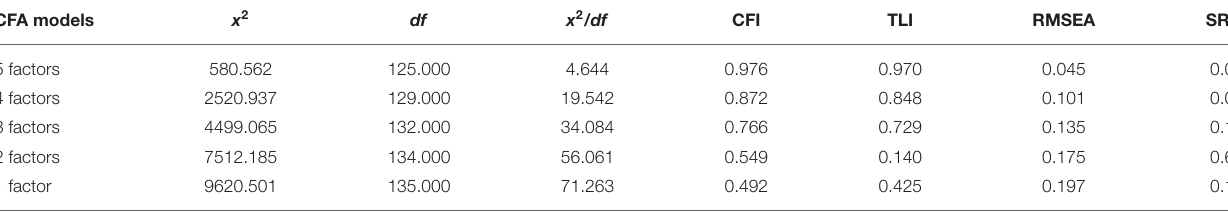
TABLE 2 | Testing the discriminant validity of the